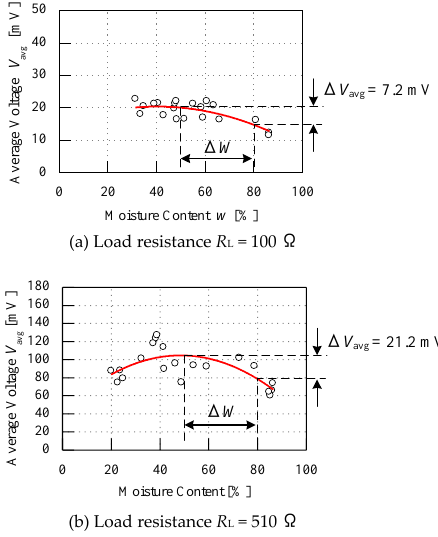
Figure 10. Graph of different load resistance.